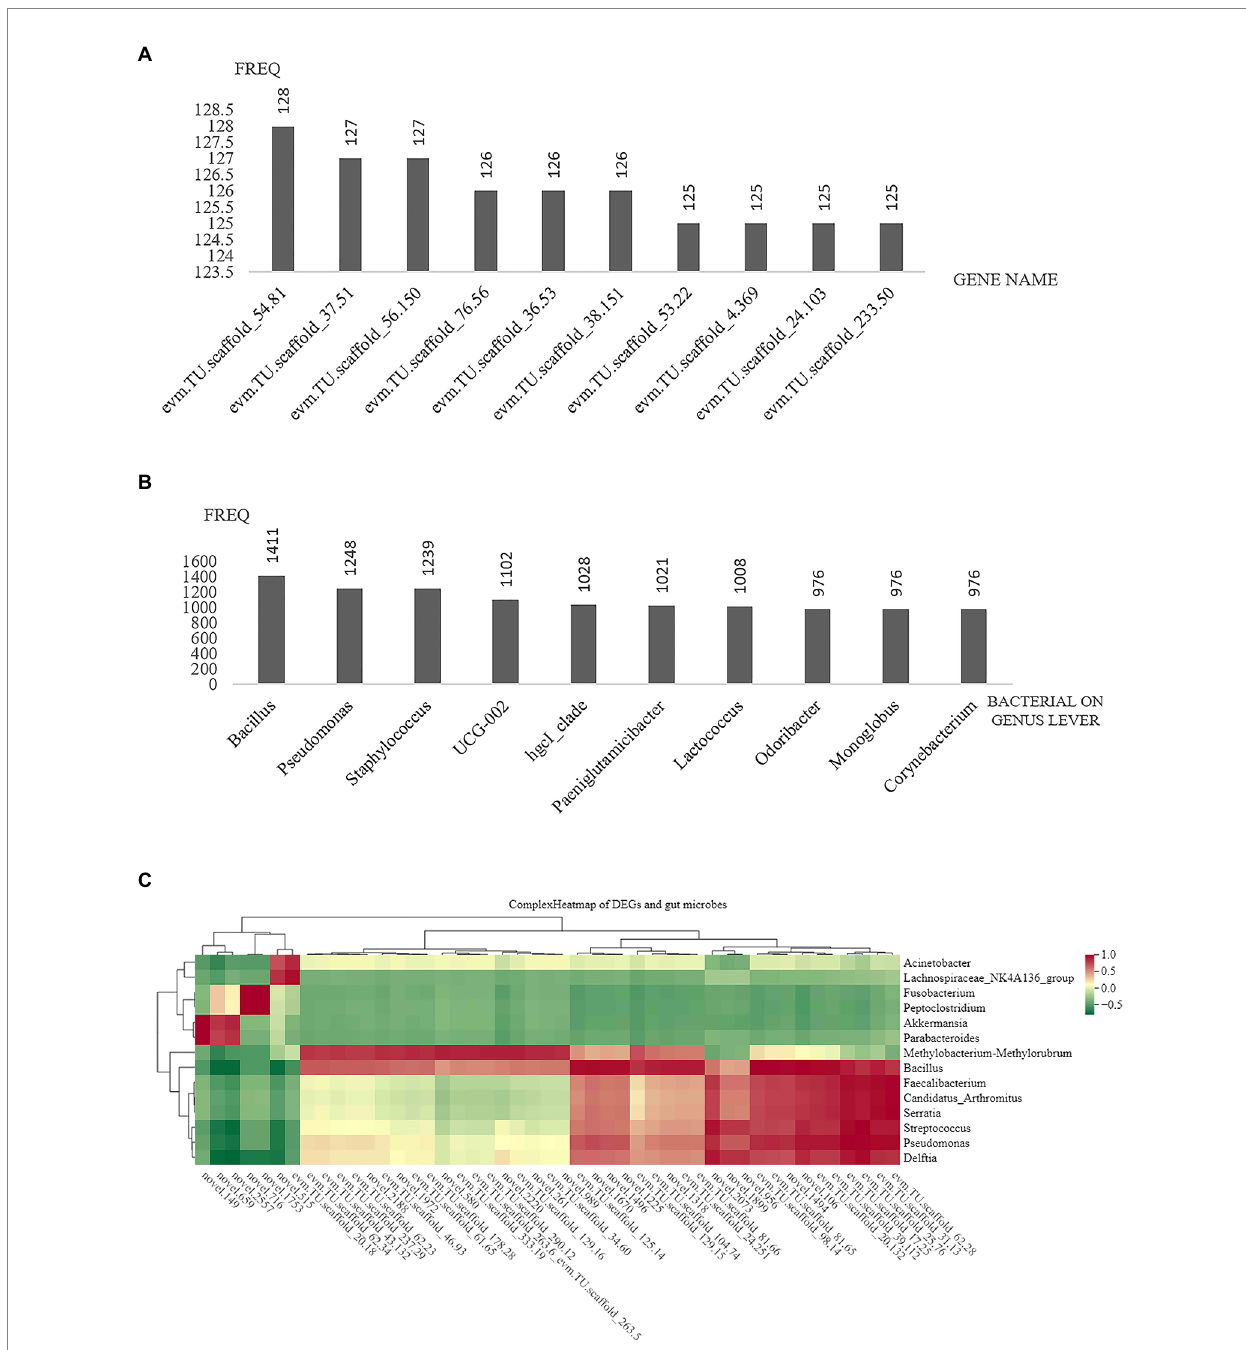
FIGURE 6 Relationship between differentially expressed genes and microbial community composition at the genus level. (A) Top 10 DEGs related to intestinal microbes. (B) Top 10 bacterial genera related to DEGs. (C) Heatmap of DEGs and intestinal